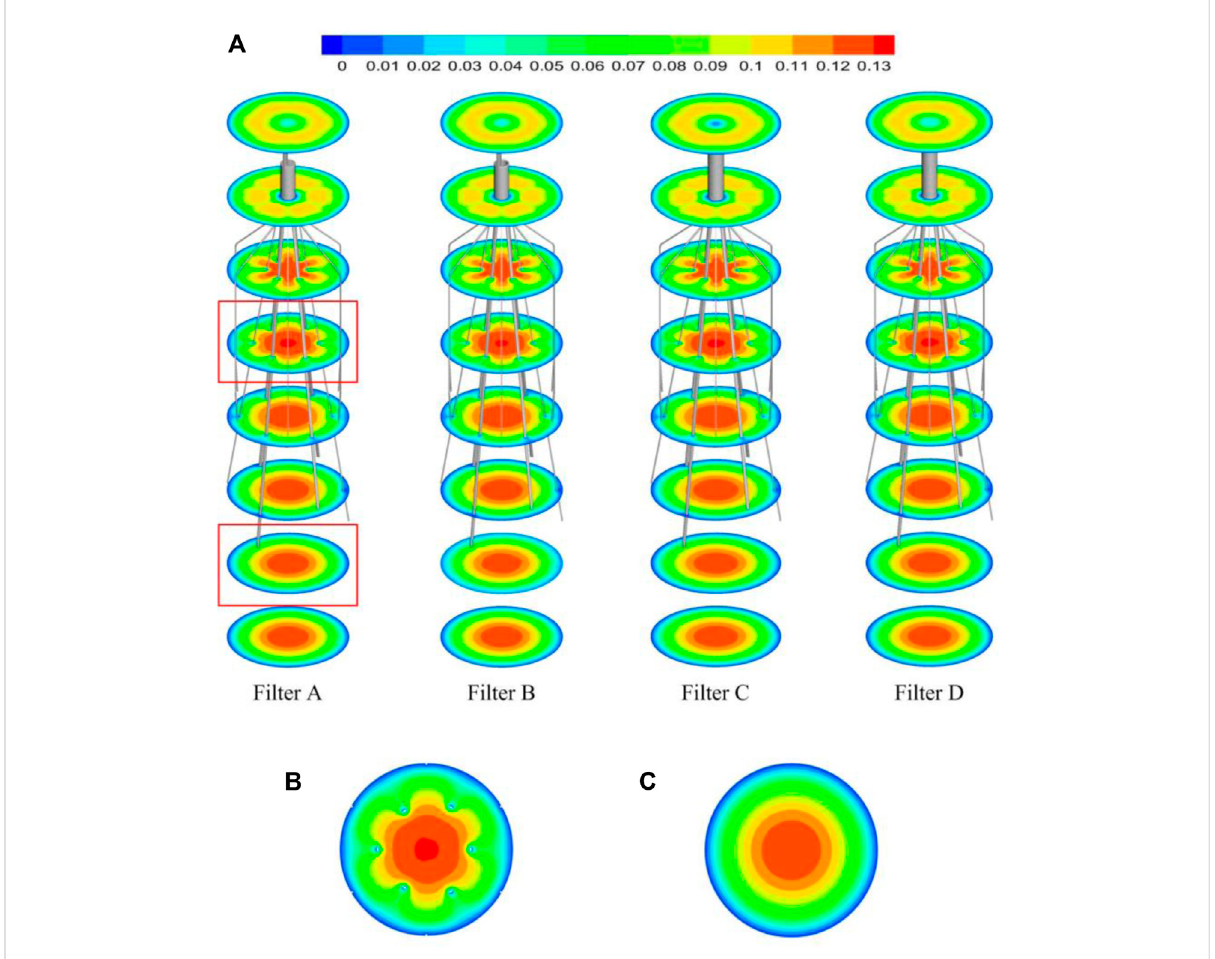
FIGURE 8 (A) Thevelocitydistributioninthecrosssection; (B) thevelocitydistributioninthecrosssectionaffectedbythe fi lter; (C)